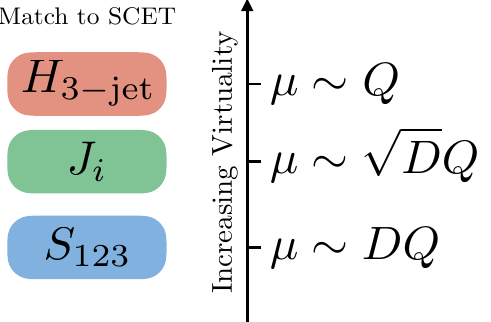
Figure 1. Illustration of the natural scales of the functions appearing in the factorization theorem of the trijets phase space